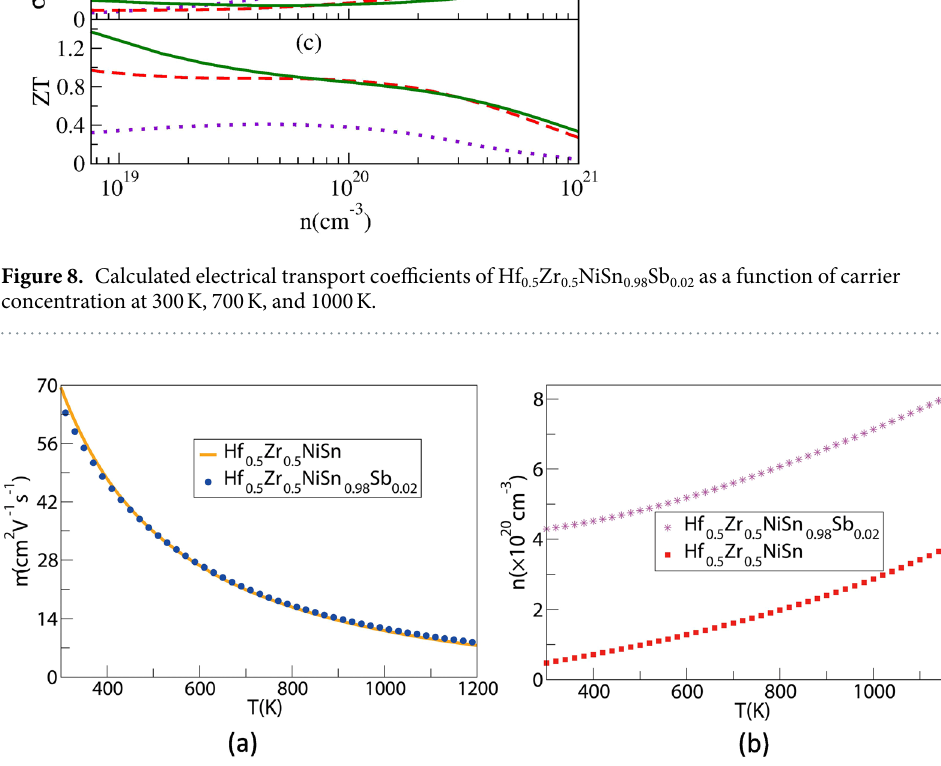
Figure 9. Calculated μ ( a ) and n ( b ) of Hf 0.5 Zr 0.5 NiSn 1 − y Sb y (y = 0, 0.02) as a function of